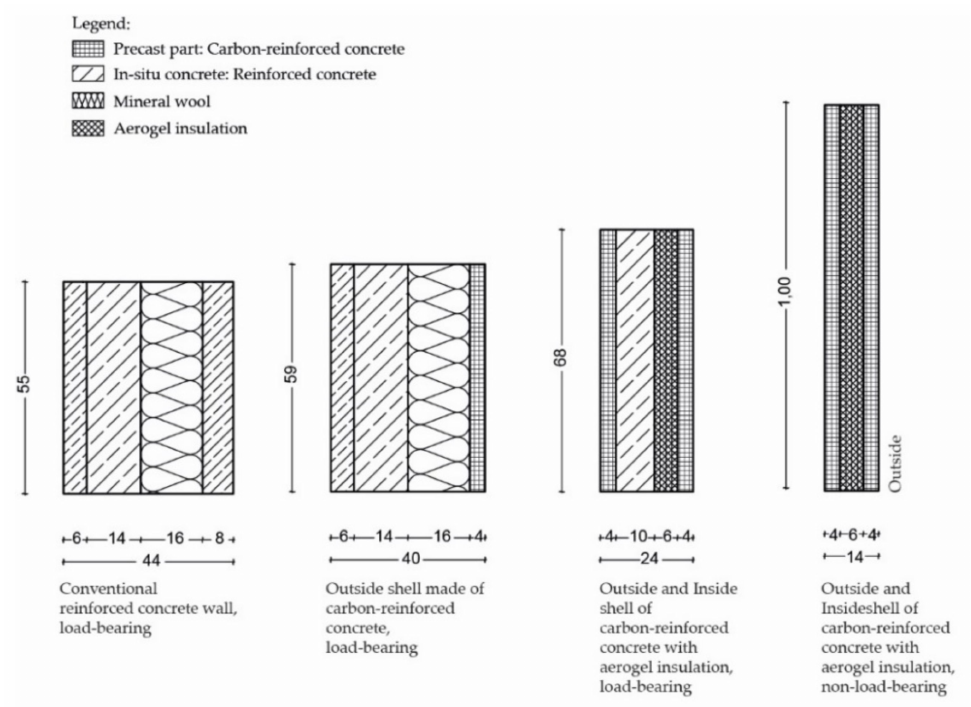
Figure 7. Comparison of different concepts for concrete facades: high-performance materials can significantly reduce wall structures, thus lowering the gray energy in building materials (mass of all elements: 200